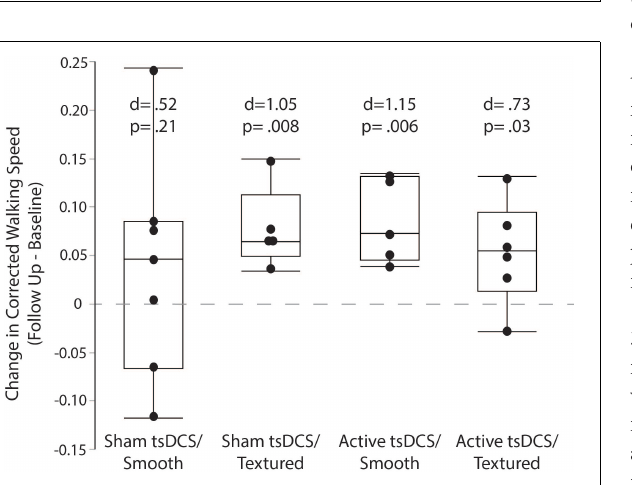
FIGURE 7 | Corrected walking speed across each trial for all study participants.